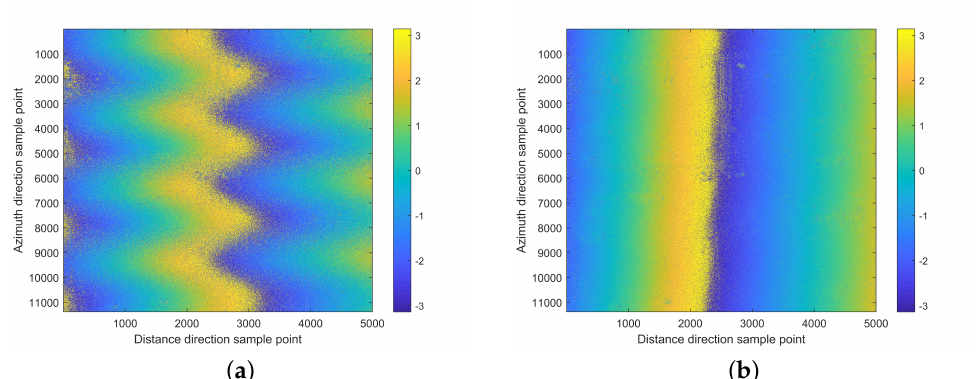
Figure 11. The comparison of interference fringe results. ( a ) The comparison method; ( b ) the proposed method.